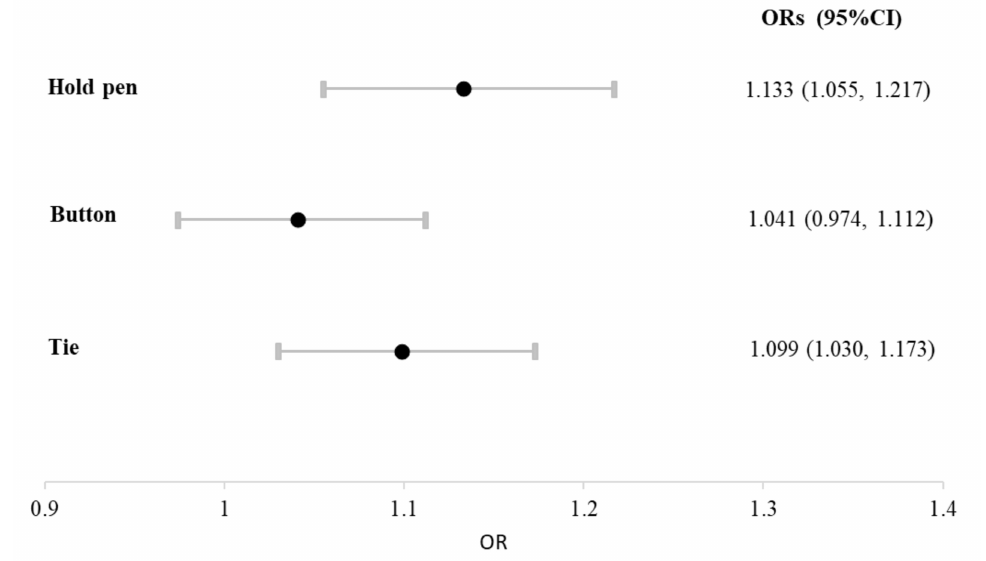
Figure 1. Association of disability in three hand fine motor skills with the presence of dementia in patients with moderate-to-advanced Parkinson’s disease (PD). After adjustments for age, sex, and PD severity by using multivariate logistic regression, dementia was significantly associated with disability in pen holding and knotting but not